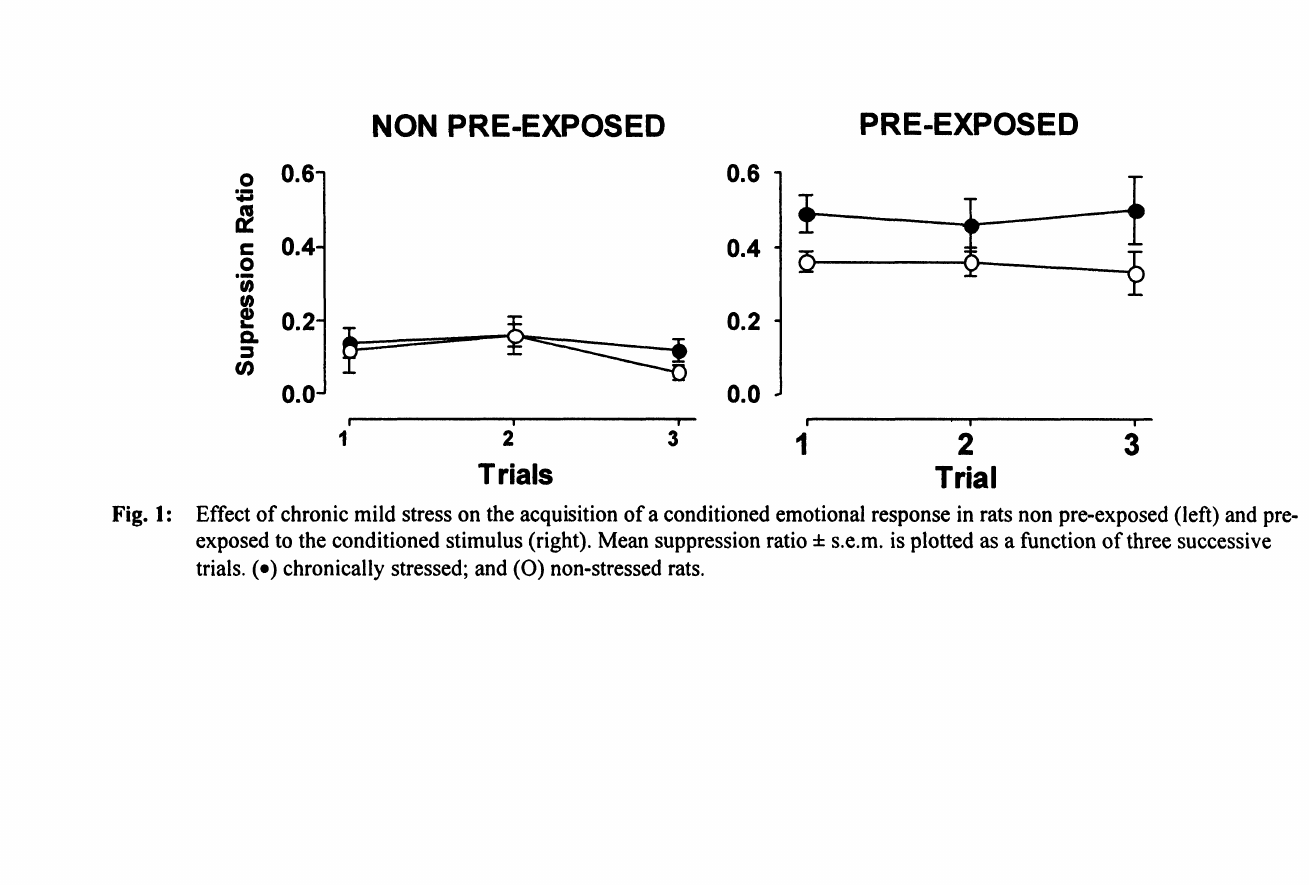
NON PRE-EXPOSED PRE-EXPOSED